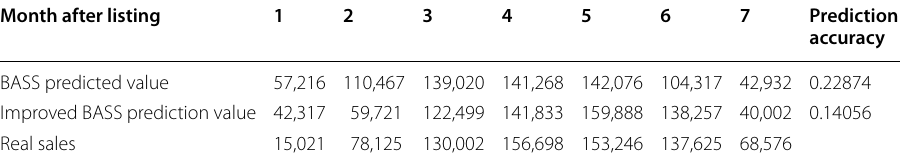
Table 3 Improved BASS algorithm and analysis of the accuracy of the prediction value of the BASS